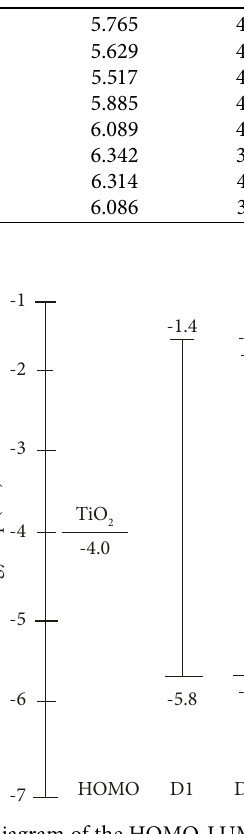
Figure 5: Schematic diagram of the HOMO-LUMO energy levels of the DMSO-solvated D1 and D1.1-D1.7 dyes were estimated by using the B3LYP/6-311++G ∗∗ level of